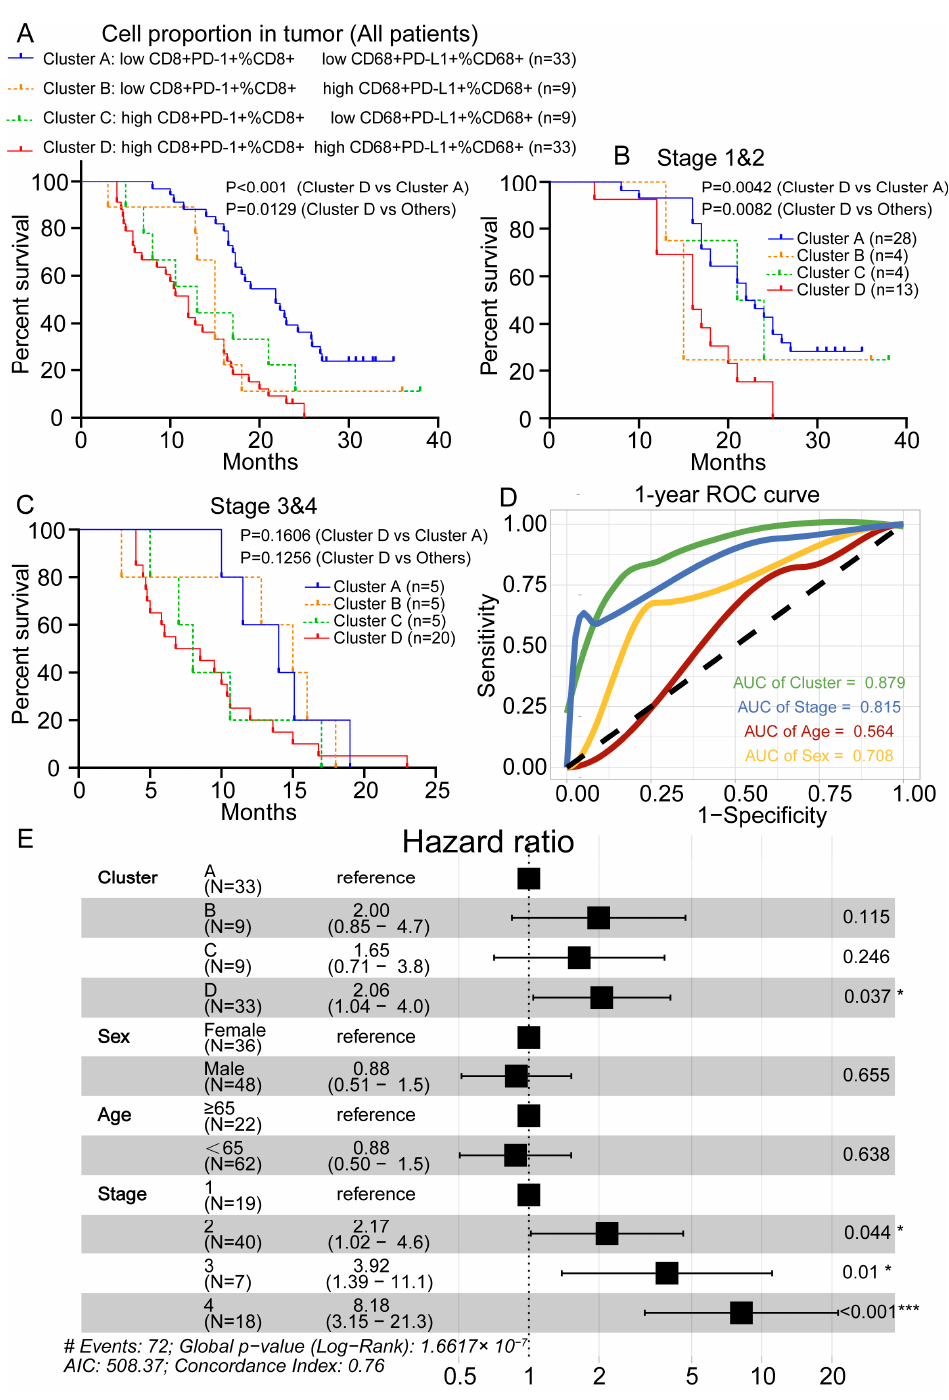
Figure 6. Establishment of a multivariate Cox model and assessment of its prognostic significance.